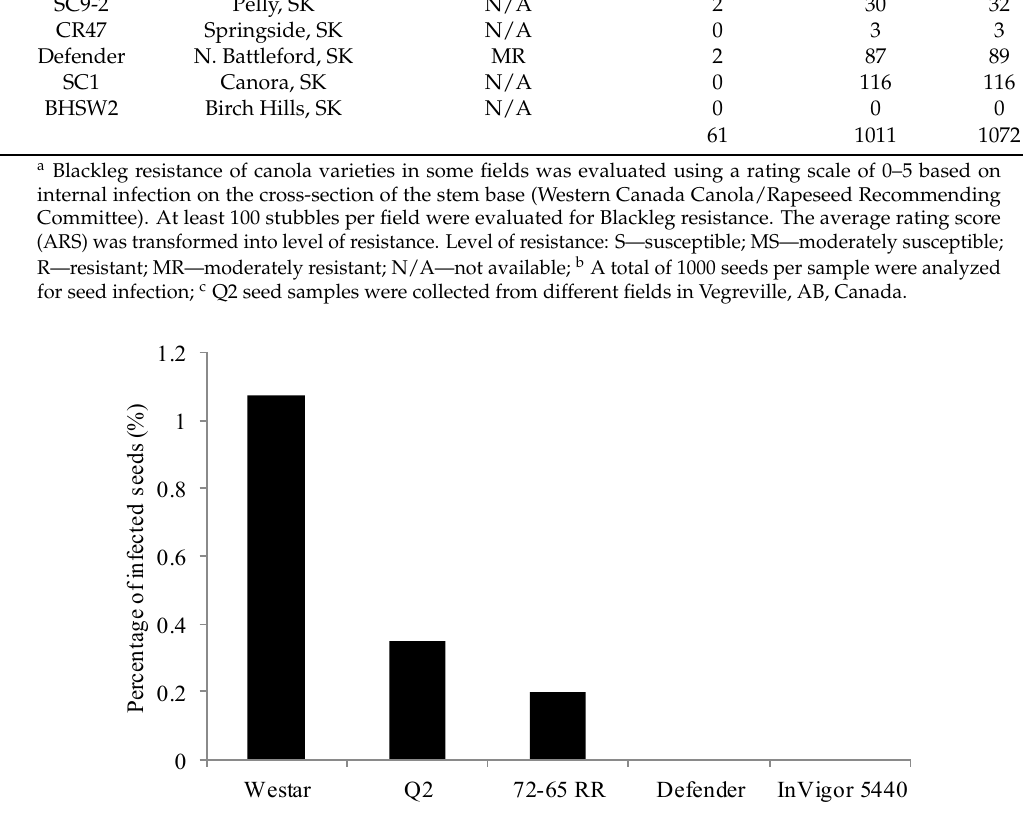
Table 1. Summary of Blackleg isolates recovered and identified from canola seed lots collected from co-op sites across Western Canada in 2011.